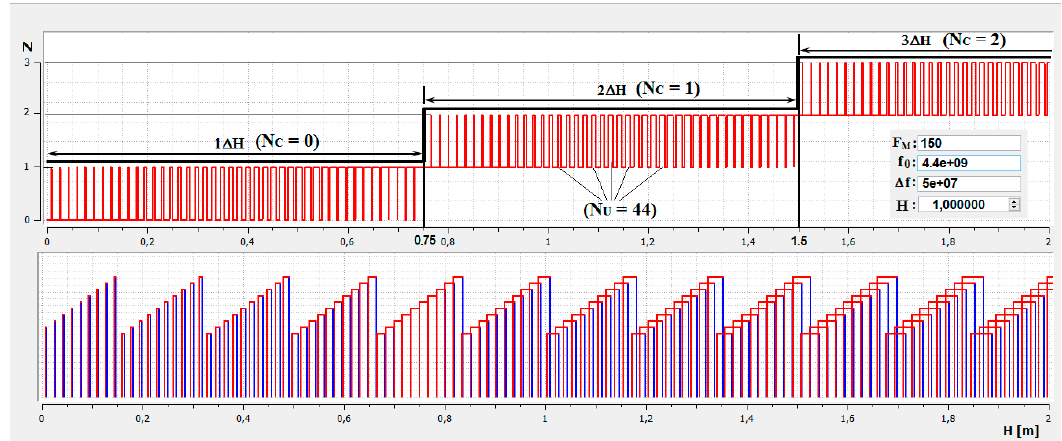
Figure 5. Simulation of number of unstable height pulses for the considering radio